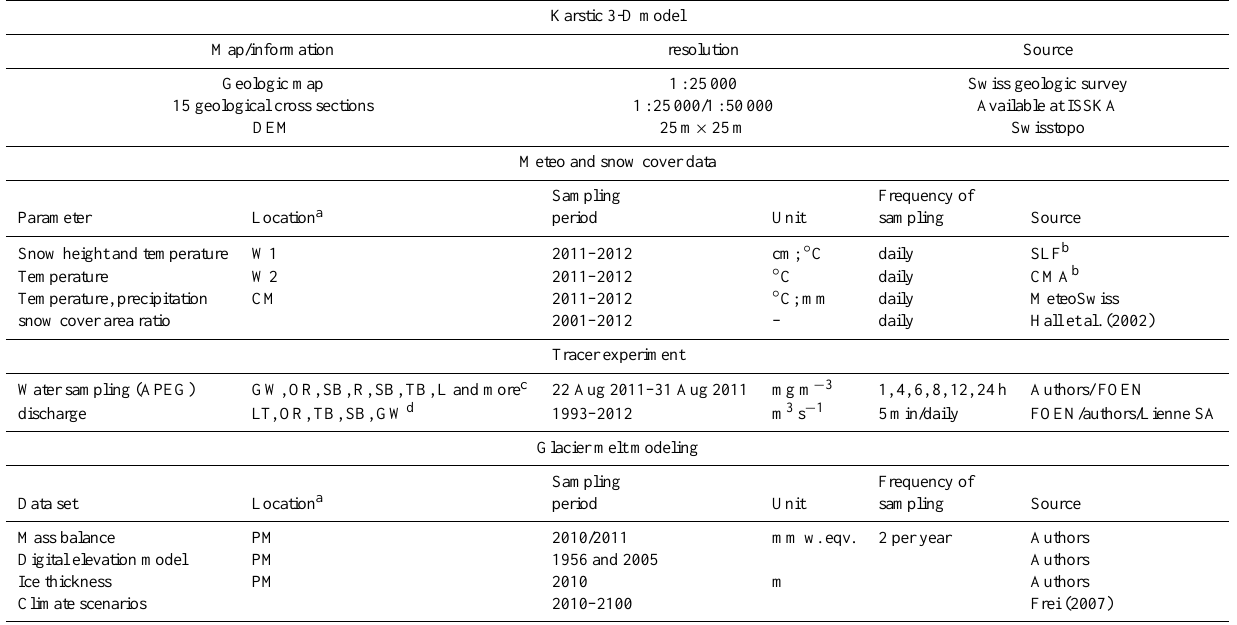
Table 1. Overview of available data and observations.